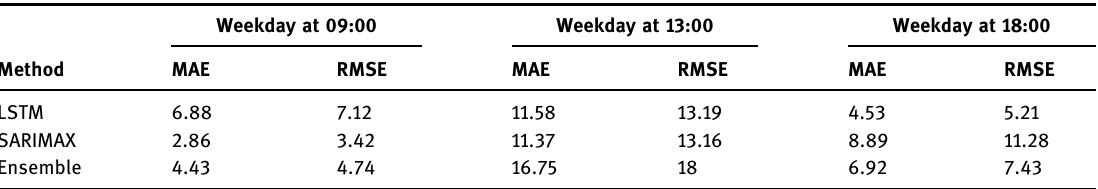
Table 5: Evaluation of methods with visitor trend data on a weekday Weekday at 09:00 Weekday at 13:00 Weekday at 18:00